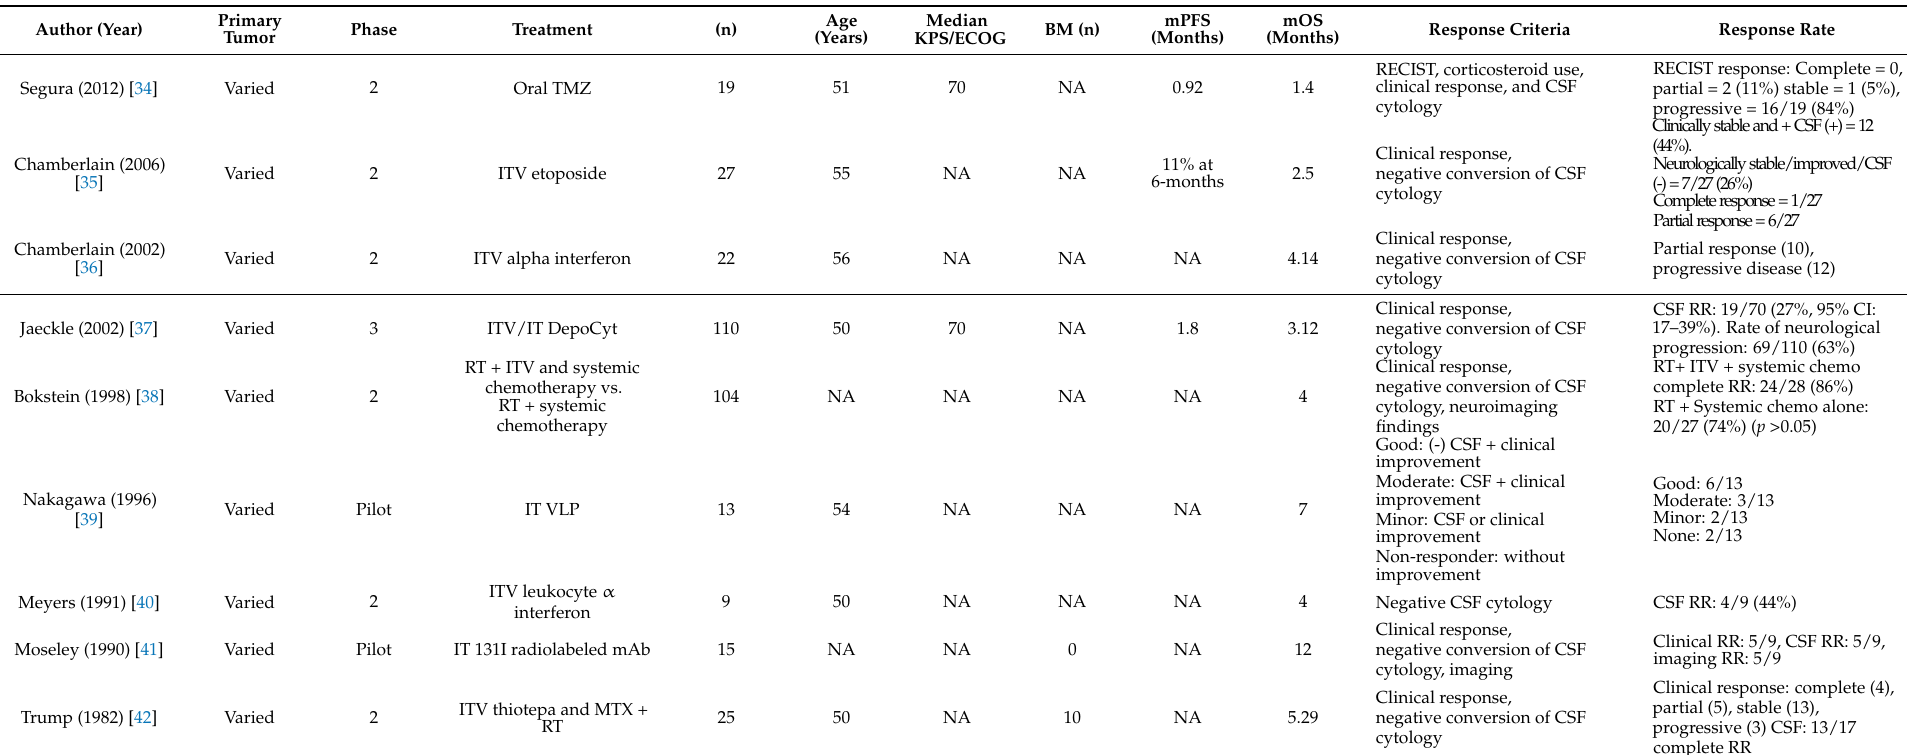
Clinical response, negative conversion of